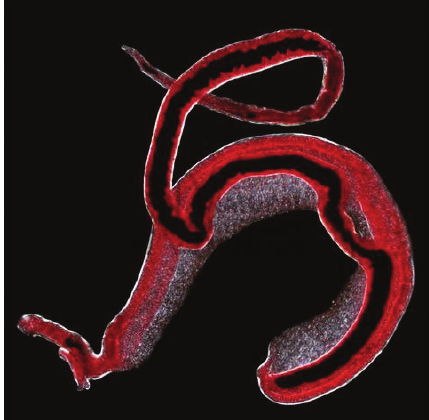
Figure 2: Adult worms paired structure. Magnified image by Light microscopy × 40. can be seen the longer female worm residing in the gynaecophoric channel of the shorter male, building a paired worm structure. From Natural History Museum,